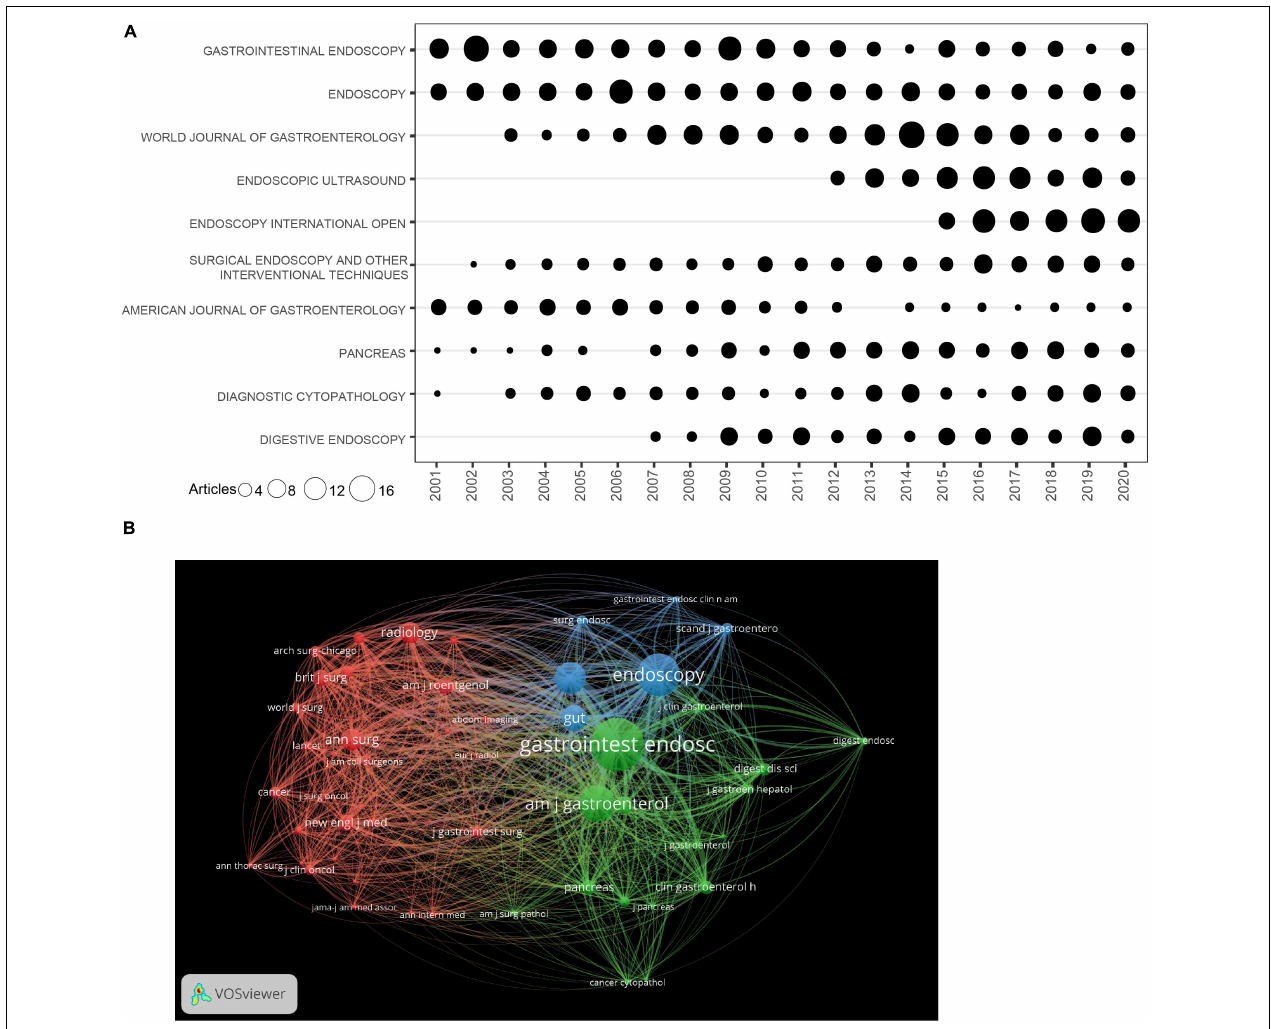
FIGURE 4 | (A) The number of publications for the top 10 journals per year. (B) The network map of journals for EUS research.